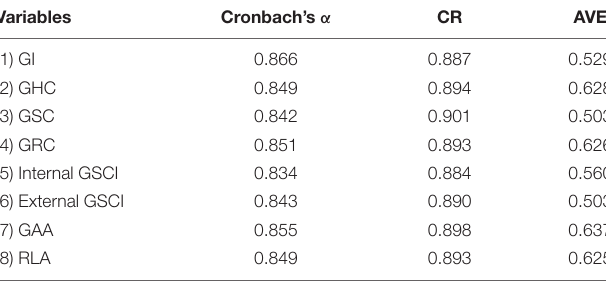
TABLE 3 | Reliability, internal consistency and convergent validity.